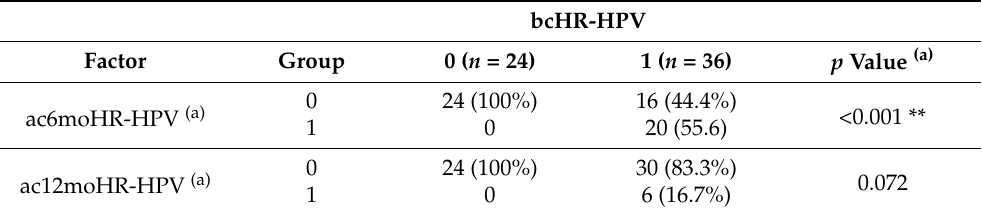
Table 1. HR-HPV infection before conization (bcHR-HPV) at 6 (ac6moHR-HPV) and 12 months after conization (ac12moHR-HPV).